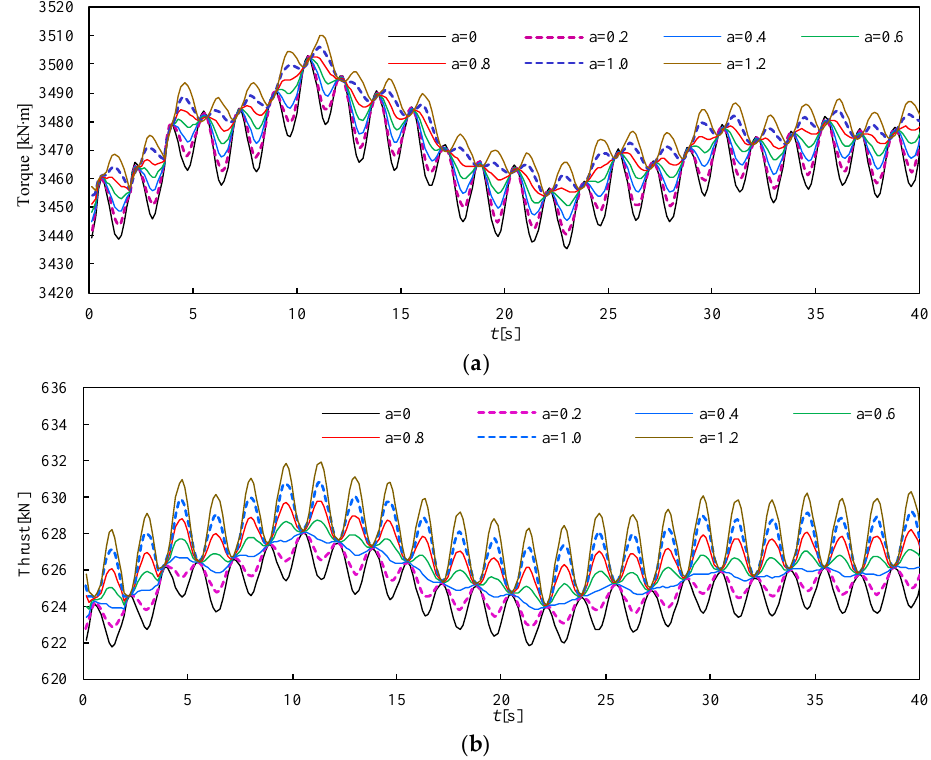
Figure 14. Torque and thrust response of the wind turbine rotor under wind shear conditions for U hub = 11.4 m/s. ( a ) Torque response; ( b ) thrust response.